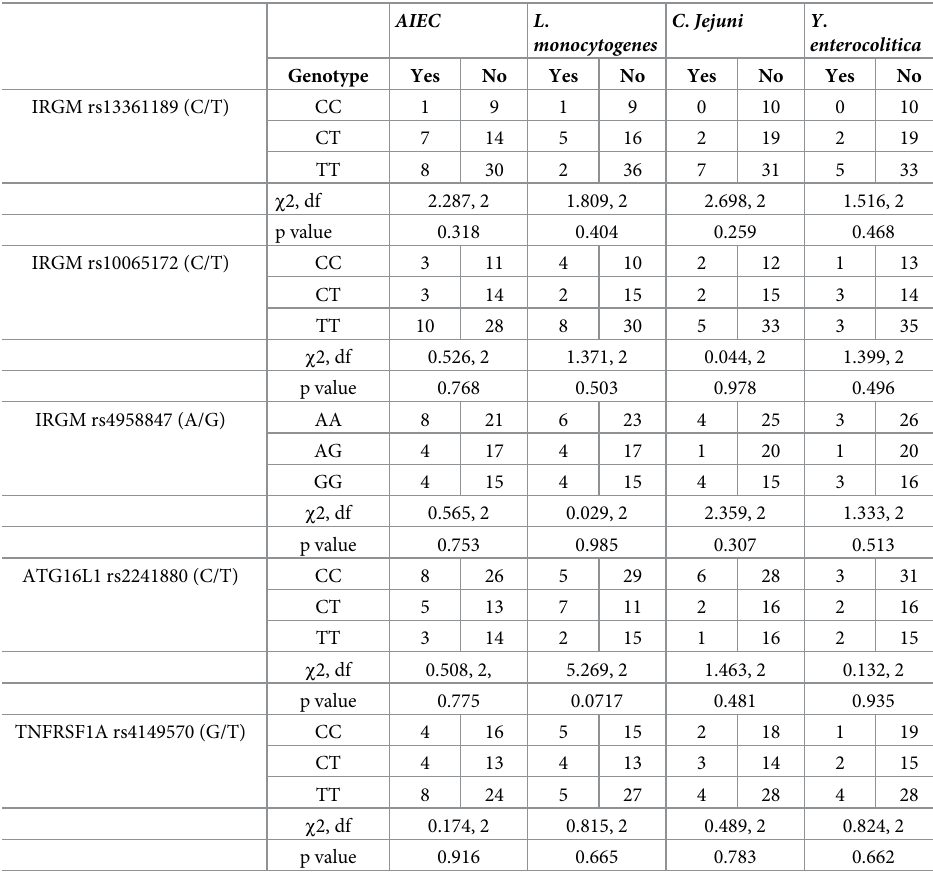
Table 5. Association of SNPs genotype with bacterial infection or persistence in CD